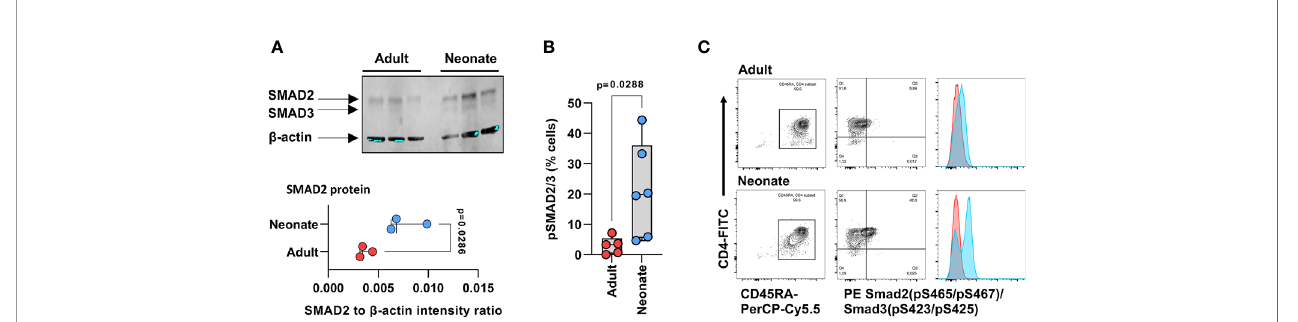
FIGURE 3 | Expression andactivity of SMAD2 and SMAD3 in naive neonataland adultCD4 T cells. (A) Westernblot detection of native SMAD2 andSMAD3in magnetic bead-puri fi edneonatal and adultnaïve CD4T cells (3 independent samples per age groups), andcorresponding signal intensity for SMAD2quanti fi cation relative to b -actin (lower panel). p value by two-tailed unpairedt-test; (B) SMAD2and SMAD3 phosphorylation at serine residues 465 & 467, and serine residues 423 & 425 sites, respectively, by fl ow cytometry, inisolated naïve CD4T cells(gatedonCD4 + CD45RA + cells) after one hourincubation with TGF- b . p value also bytwo-tailedunpaired t-test; (C) Representative fl ow cytometrydata in (B) , with histogramsfor cellsincubatedwith TGF- b in blue andhistogramsinabsence of TGF- b in red.